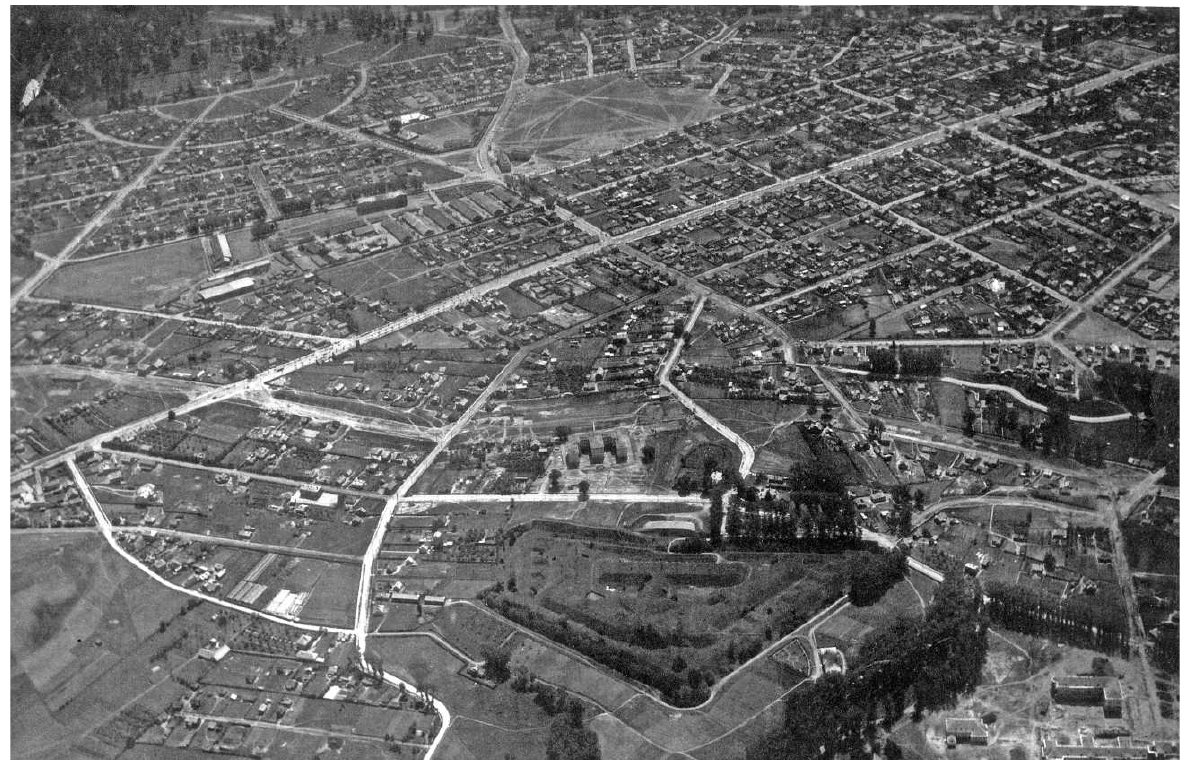
Fig 2. Fort VII around 1930 (Kaunas County Archives, Fund 218, Inventory